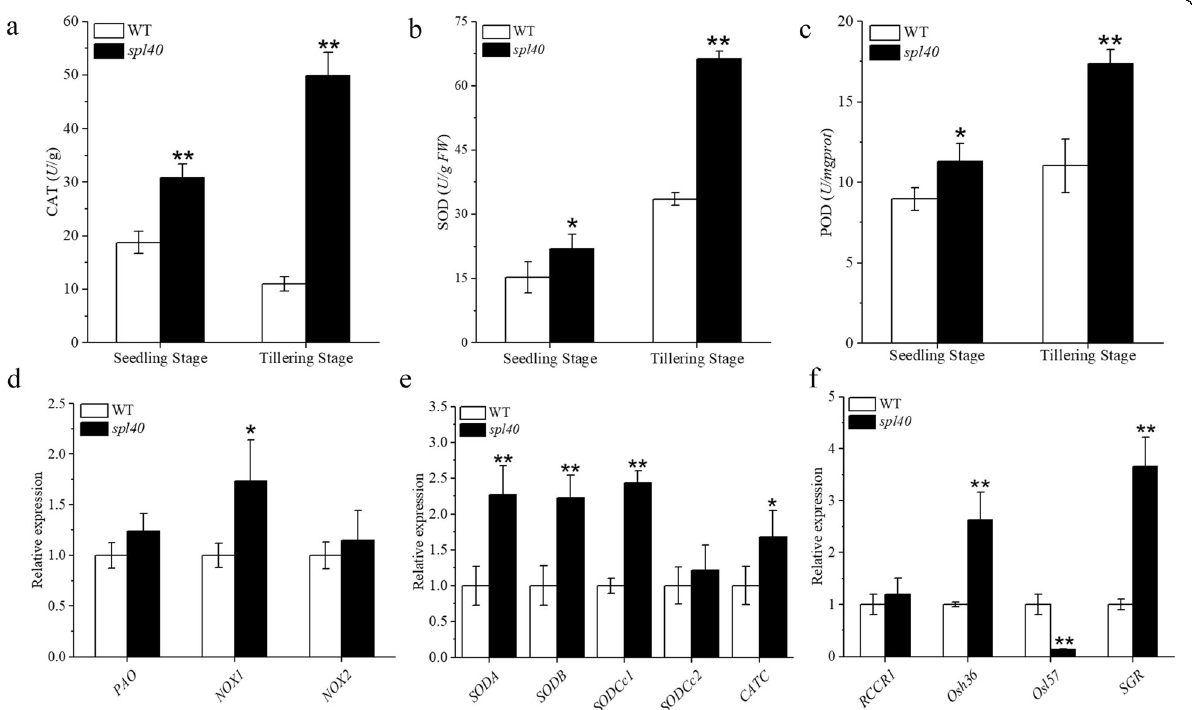
Fig. 4 ROS scavenging enzymes and associated genes. a – c Enzymatic activities of CAT, SOD and POD at seedling and tillering stage. SOD, superoxide dismutase; CAT, catalase; POD, peroxidase. d Expression levels of genes encoding ROS-generating enzymes. e Expression levels of ROS detoxification-related genes. f Expression levels of senescence-related genes. Values are means ± SD ( n = 3); ** indicates significance at P ≤ 0.01 and * indicates significance at P ≤ 0.05 by Student ’ s t